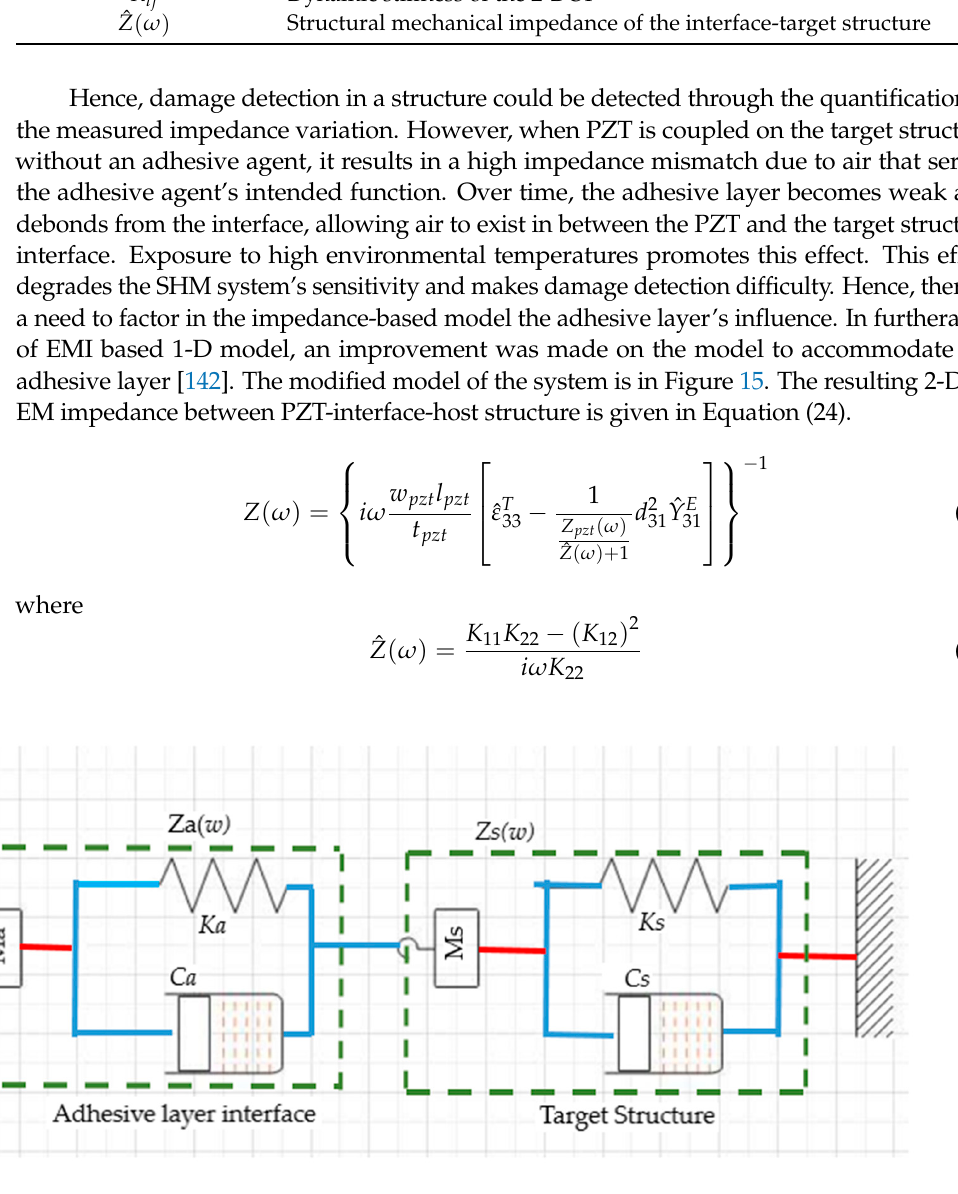
Figure 15. Modified PZT–host structure interface [142].